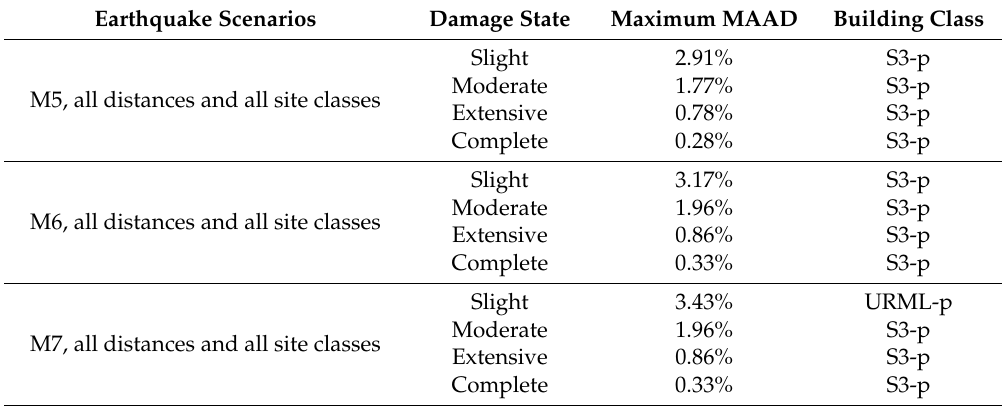
Table 2. Building classes with maximum deviation between damage probability data points and implicit fragility function observed for 53 building classes—MAAD parameter (mean of the average absolute